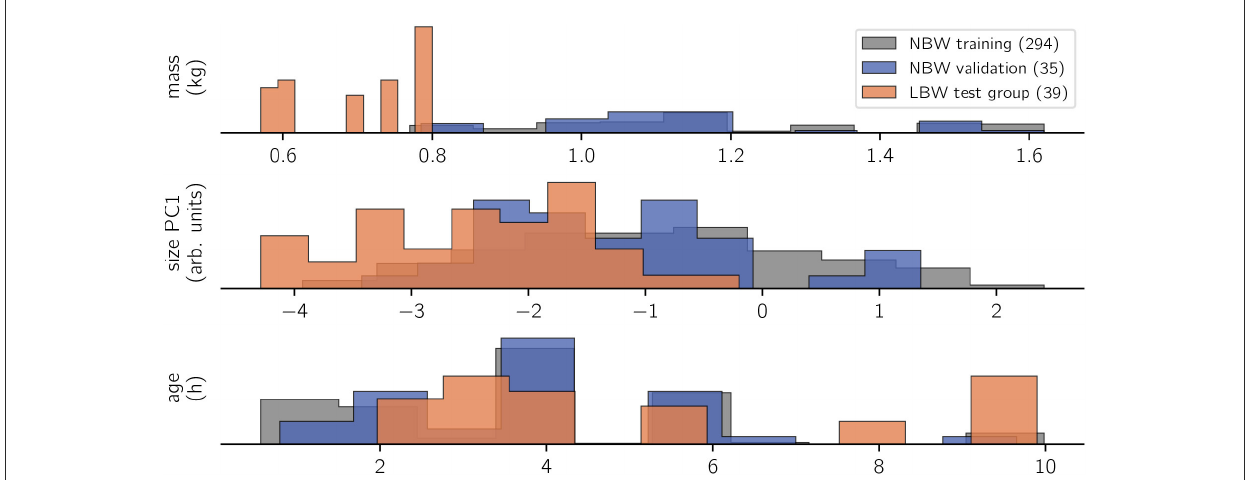
FIGURE2 Histogram of observations. Trivially, the LBW group measured the lowest body masses in the data set. This correlated with a lower body size, whereas age is rather uniformly sampled for all study groups. Recordings happened opportunistically within the first 10 life hours of the animals, repeated measurements were possible. Number of strides per class are indicated in brackets on the legend. Bar heights are scaled by sample size to show relative value